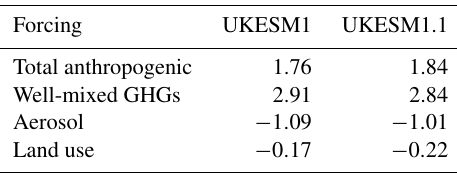
Table 3. Global annual mean effective radiative forcings (Wm − 2 ) in UKESM1.1 and UKESM1. UKESM1 values are taken from O’Connor et al. (2021). The ERFs are calculated for the year 2014 relative to an 1850 preindustrial control climate (Pincus et al., 2016). Note that GHGs are greenhouse